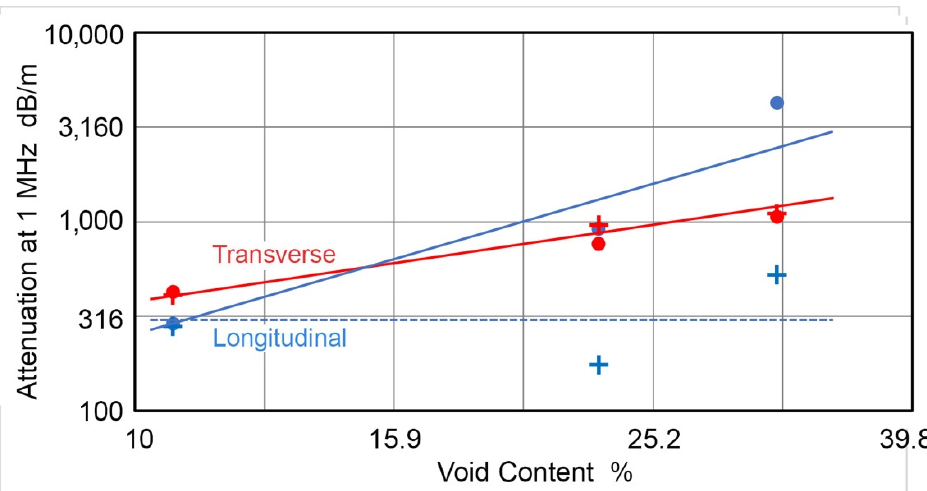
Figure 11. Attenuation at 1 MHz (dB/m) vs. void content (%) of mortar samples. Blue dots and + are longitudinal attenuation and matched to the α 1M ‐ V 3 relation (blue line). Red dots are transverse attenuation, matching to the α τ 1M ‐ V relation, shown by red line. In both wave modes, + symbols represent attenuation in the saturated conditions.